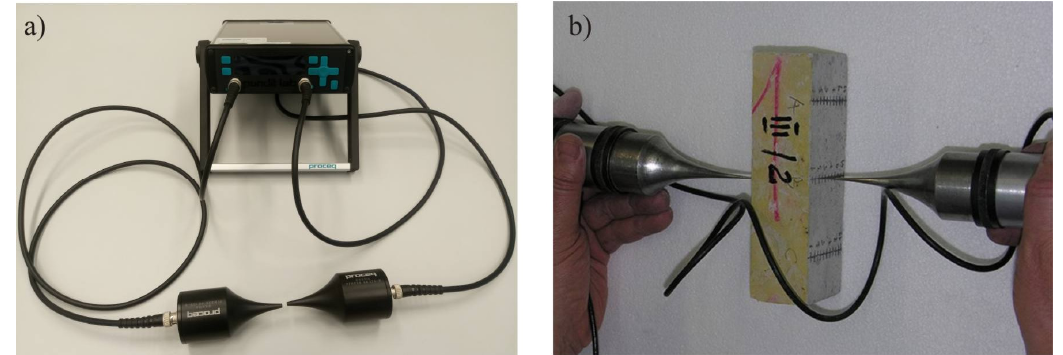
Figure 7. Example view: ( a ) head and probe for ultrasonic testing; ( b ) floor sample tested using the ultrasonic method.